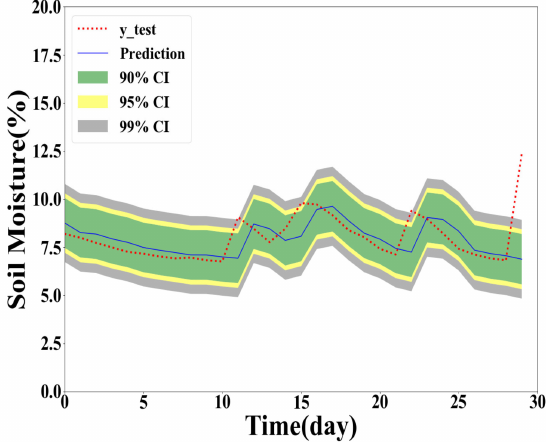
Figure 11. Y(1) prediction with full training data and testing in test